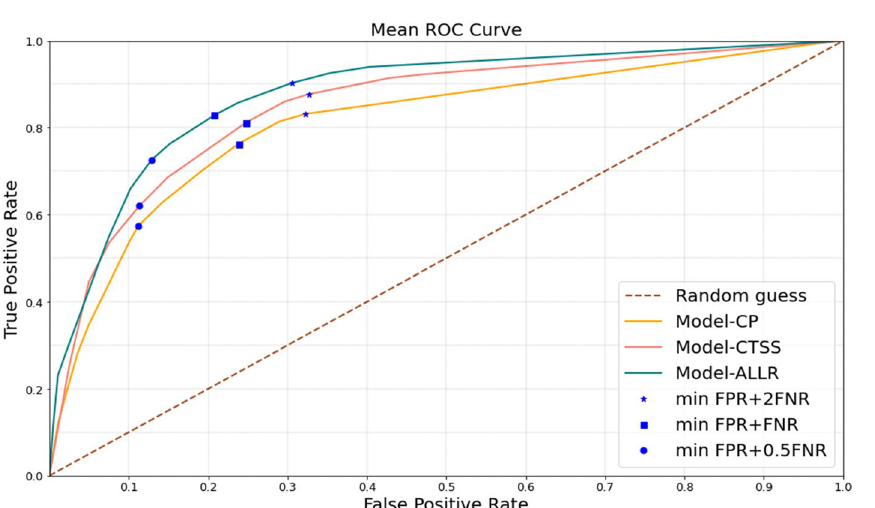
Figure 3. Mean ROC curve. The figure shows the ROC curves obtained by taking the mean of validation ROC curves over 50 iterations for predicting need for ventilation for the three models. The blue markers on the curves show the operating points where the mentioned cost function is